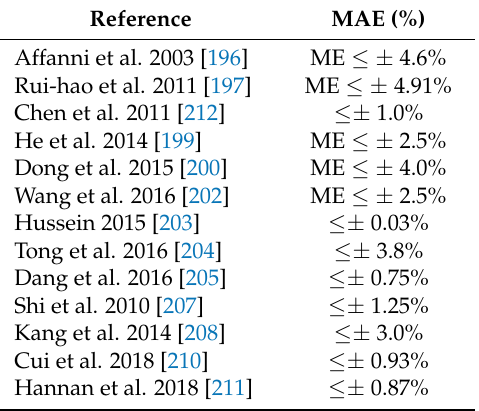
Table 19. MAE/ME of the NN-based SOC estimation method.